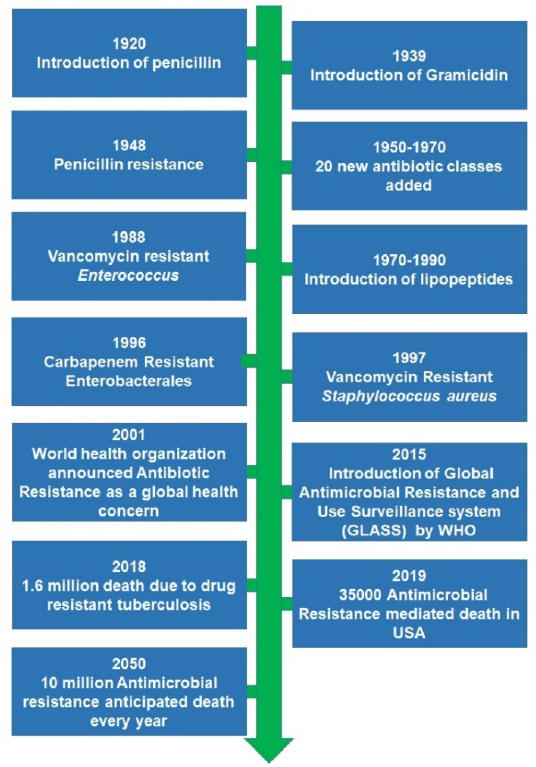
Figure 3. Schematic representation of historical aspects for the development of antimicrobial re ‐ sistance.